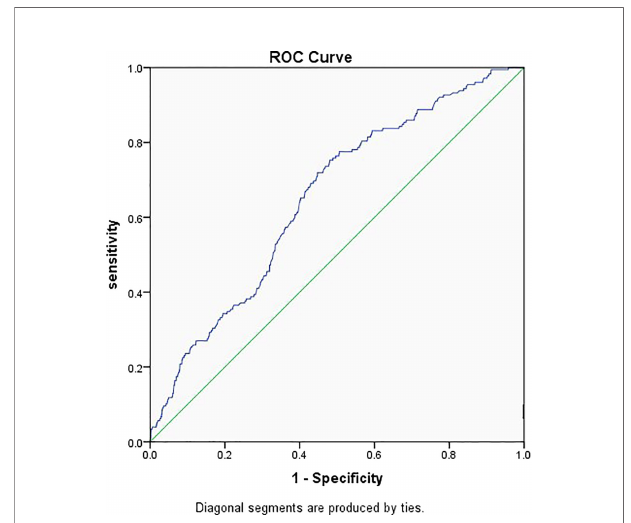
FIGURE 2 | Receiver operator characteristic curve of the embryo stage, BMI, previous history of ectopic pregnancy, and tubal factor infertility. Diagonal segments were produced by ties and the area under the curve was 0.651.